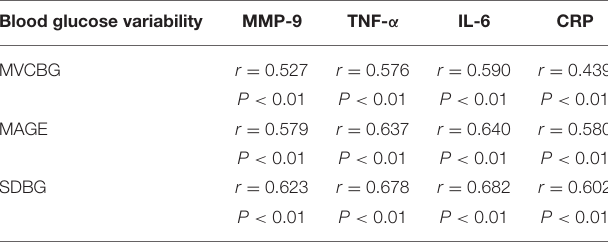
TABLE 5 | Correlation analysis of blood glucose variability indices and inflammatory factors. Blood glucose